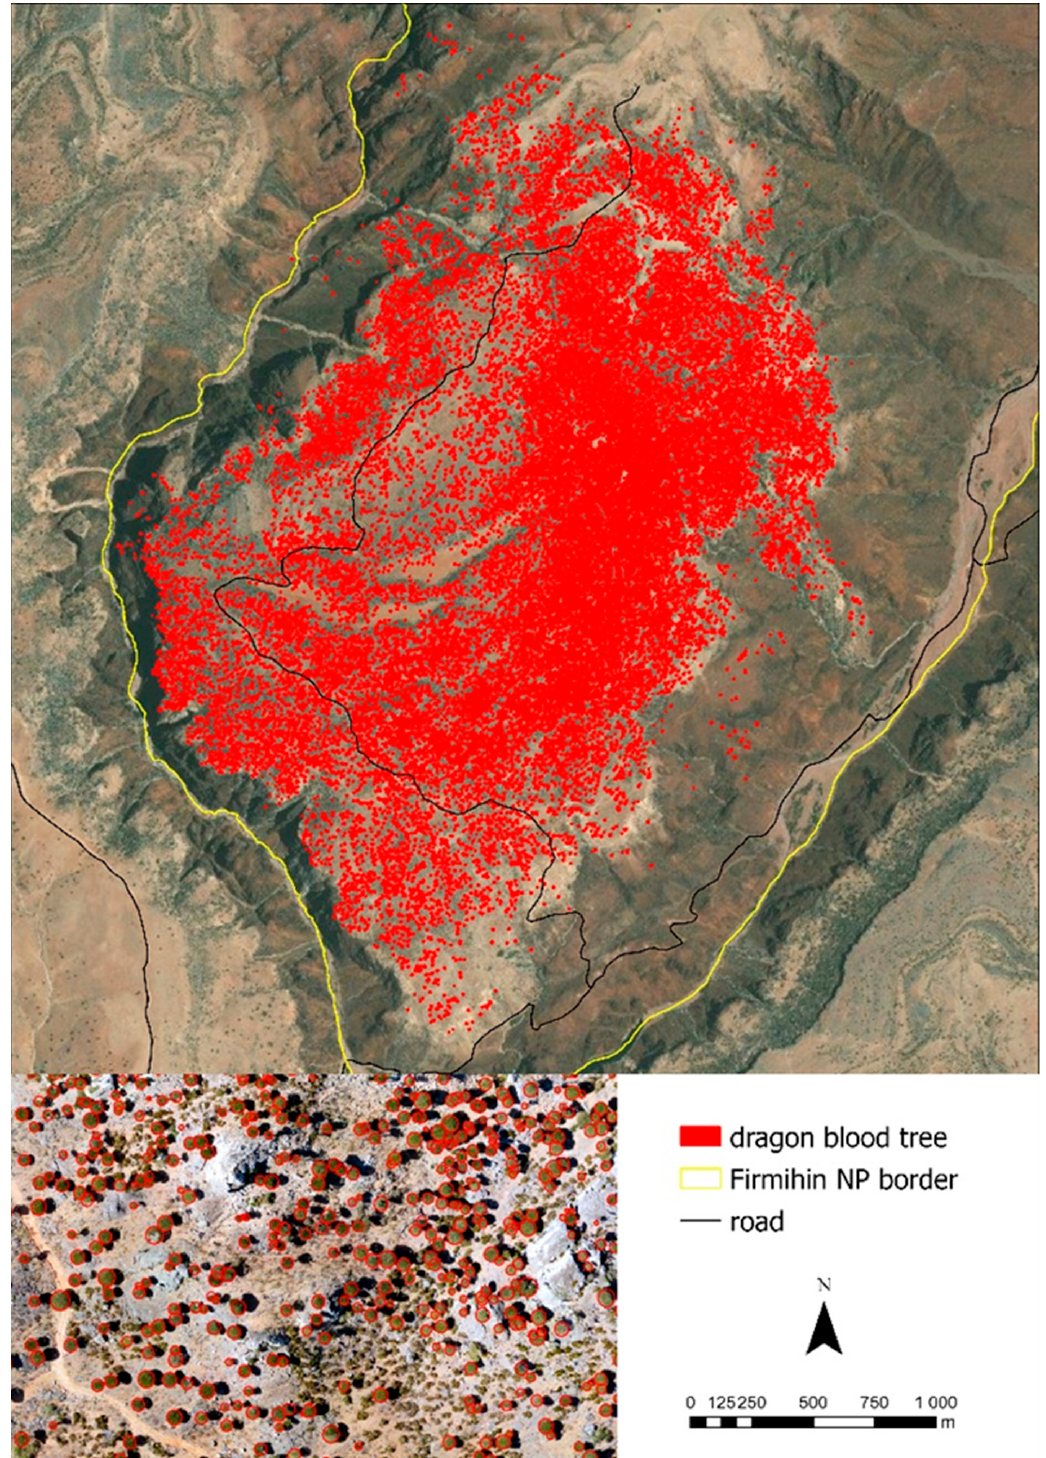
Figure 5. Firmihin forest inventory and detail of a group of inventoried Dracaena cinnabari trees showing vectorized crowns, each red dot representing an individual (living)